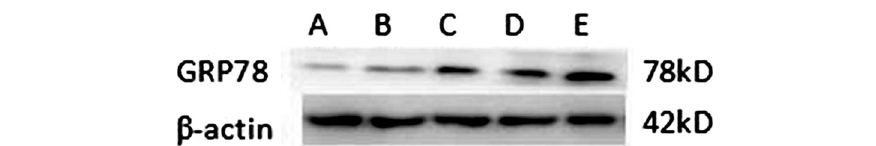
Fig. 4 GRP78 protein expressing in different HSC groups as measured using western blot. A – blank group; B – TGF- β 1 group; C, D and E – TGF- β 1 + low, middle and high dose of calcium ionophore A23187 groups